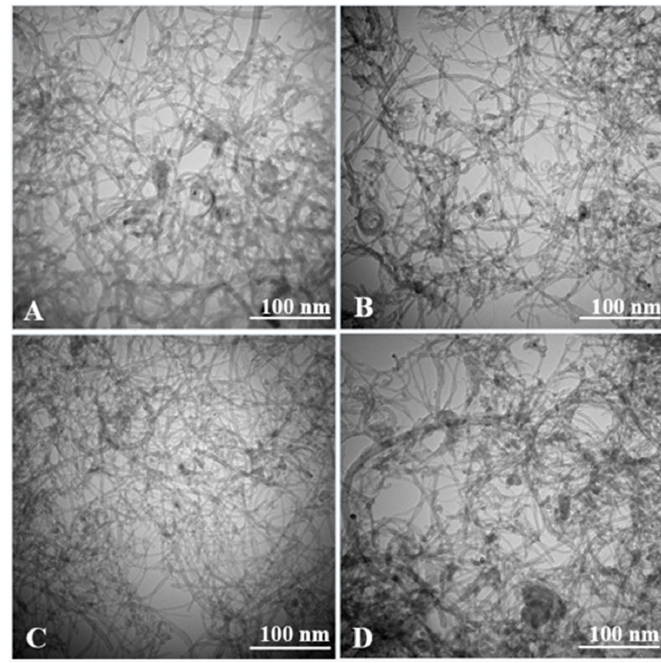
Figure 3. TEM images of refluxed ZnO/COOH-MWNTs nanocomposites produced at ( A ) 60, ( B ) 120, ( C ) 150, and ( D ) 165 min sonication times. The scale bar denotes a 100 nm length. ( C ) 150, and ( D ) 165 min sonication times. The scale bar denotes a 100 nm